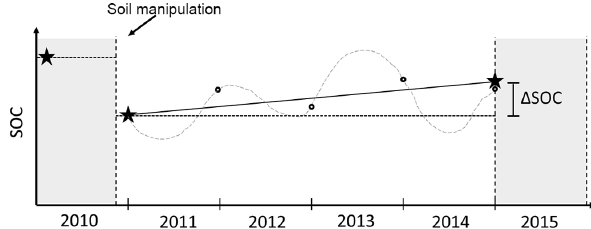
Figure 1. Schematic representation of the study concept used to de- tect changes in soil organic carbon stock ( (cid:49) SOC). Black stars rep- resent SOC measured by the soil resampling method. Black circles represent annual NECB derived using the C budget method.